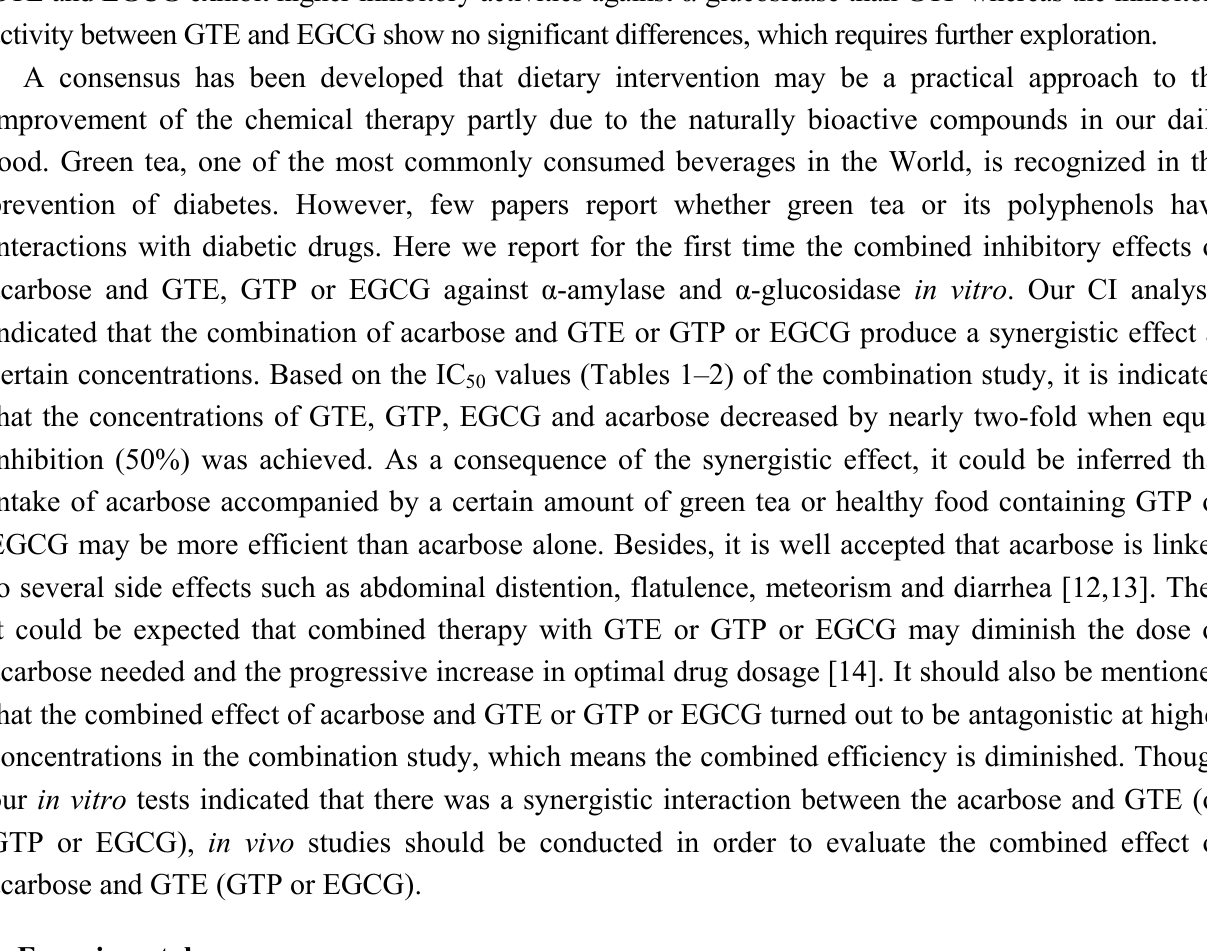
Figure 6. The CI of interaction between EGCG and acarbose of inhibition on α -amylase.